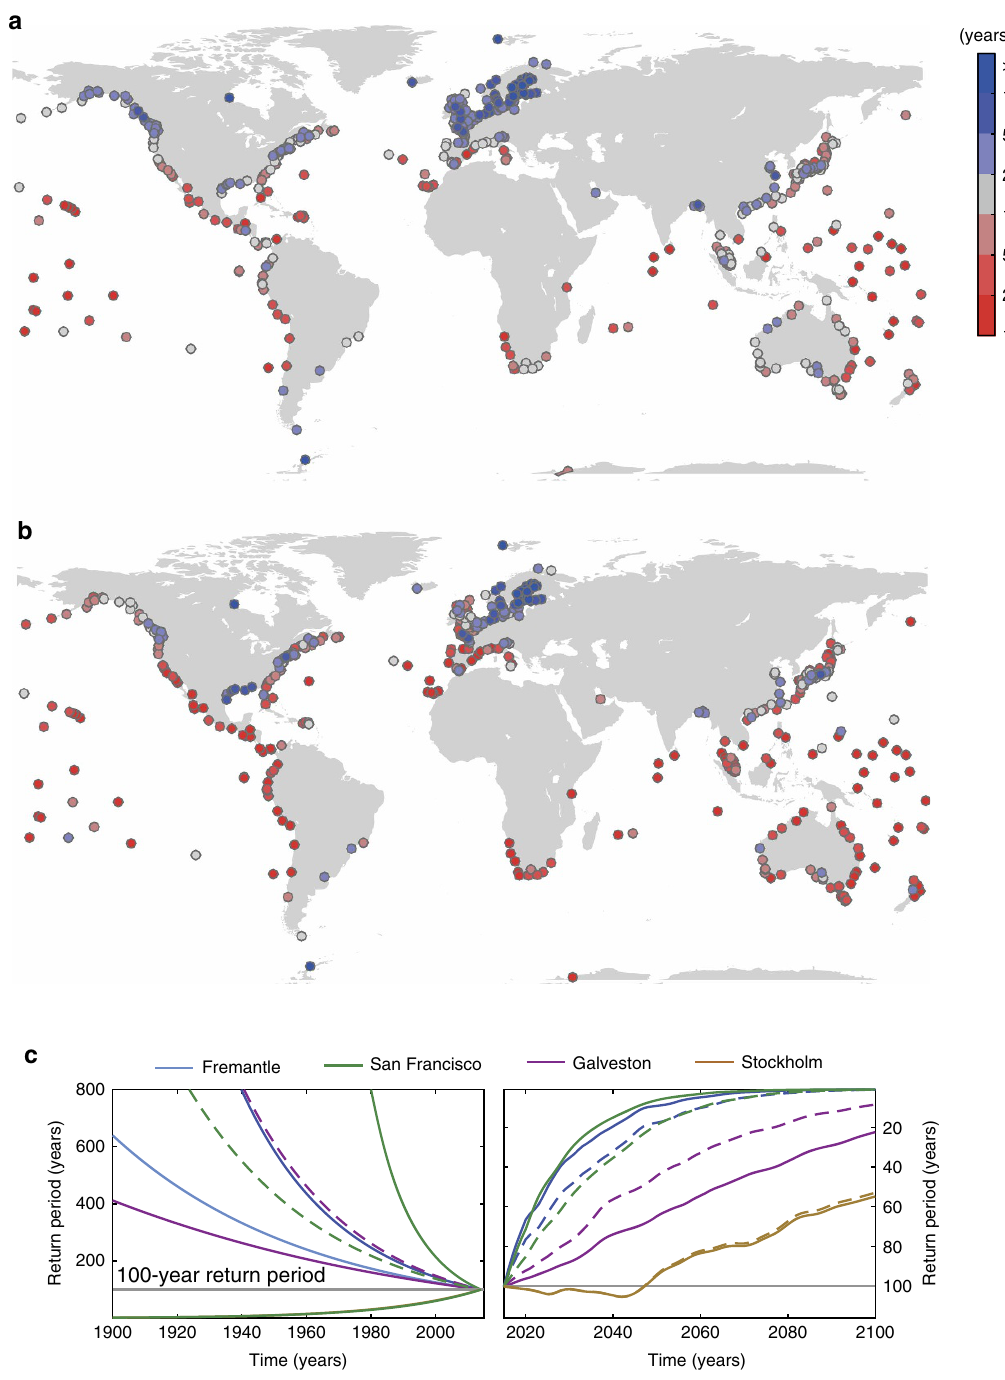
Figure 4 | Changes in return periods due to sea-level rise when using different extreme value analysis models. ( a , b ) Return period in 2050 (assuming regional relative sea-level rise (SLR) under Representative Concentration Pathway (RCP) 4.5 scenario) of present-day 100-year water level when using ( a ) Gumbel distribution with annual maxima (GUM-AMAX) and ( b ) Generalized Pareto Distribution with 99th percentile threshold exceedances (GPD99). ( c ) Changes in return period of present-day 100-year water levels through time (1900 to 2100; RCP4.5 scenario) at four selected sites: Fremantle (blue; past SLR trend 1.73mm per year), Galveston (red; past SLR trend 6.31mm per year), San Francisco (green; past SLR trend 1.87mm per year), and Stockholm (brown; past SLR trend (cid:2) 3.78mm per year). Results are shown for GUM-AMAX (dashed lines) and GPD99 (solid lines); horizontal grey line represents the 100-year return period. Locations of the four sites can be seen in the inset in Fig.